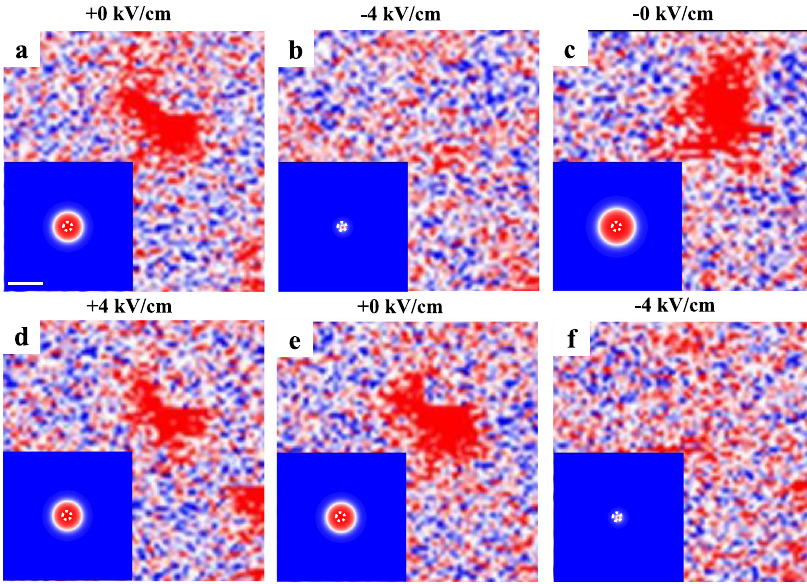
Fig. 5 Skyrmion creation/annihilation. Isolated skyrmion morphology at E = + 0 kV/cm ( a ), − 4 kV/cm ( b ), − 0 kV/cm ( c ), + 4 kV/cm ( d ), + 0 kV/cm ( e ), and − 4 kV/cm ( f ) with B bias = 55 mT. The insets in a – f show the simulation results of strain-mediated annihilation and reappearance of one single skyrmion with ε (cid:3) 110 ½ diameter pinning site with ~5% lower perpendicular anisotropy was speci fi ed, as indicated by the dashed circle in the center. The scale bar is 100 (Fig. 5e). Applying − 4 kV/cm again, the skyrmion annihilates again (Fig. 5f).